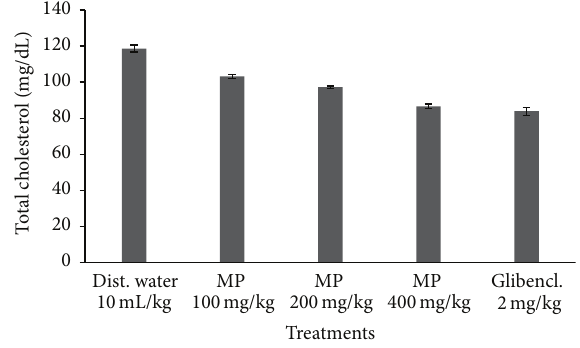
Figure 1: Total cholesterol levels in diabetic rats treated with various doses of MP